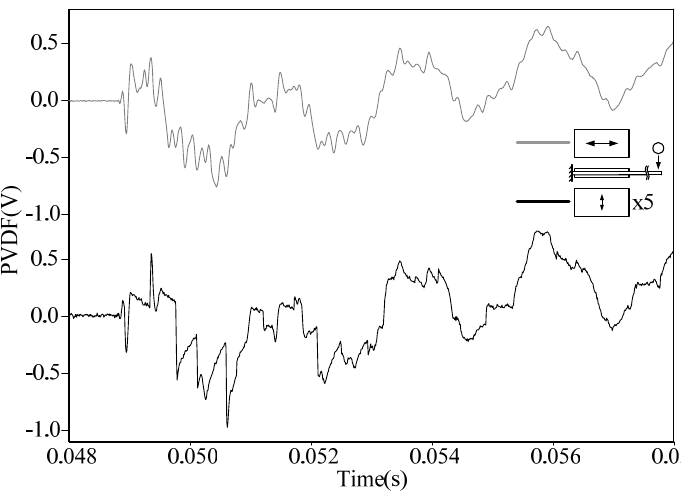
Figure 7. Measurement results of PVDF-U and PVDF-B with magnification within 10